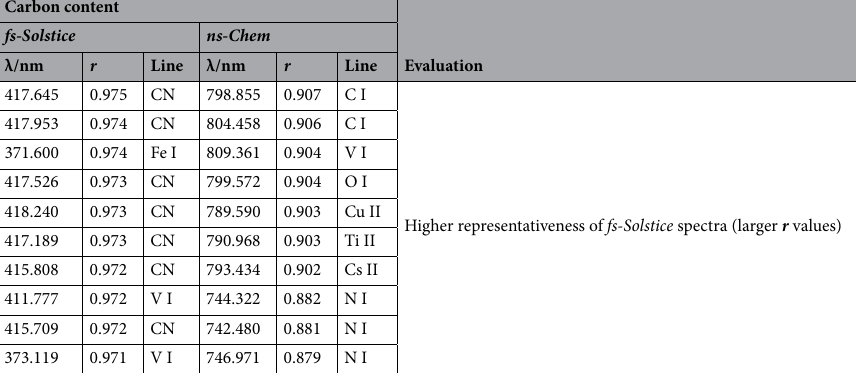
Table 1. Evaluation of fs-Solstice spectra correlation to carbon content in coal samples.